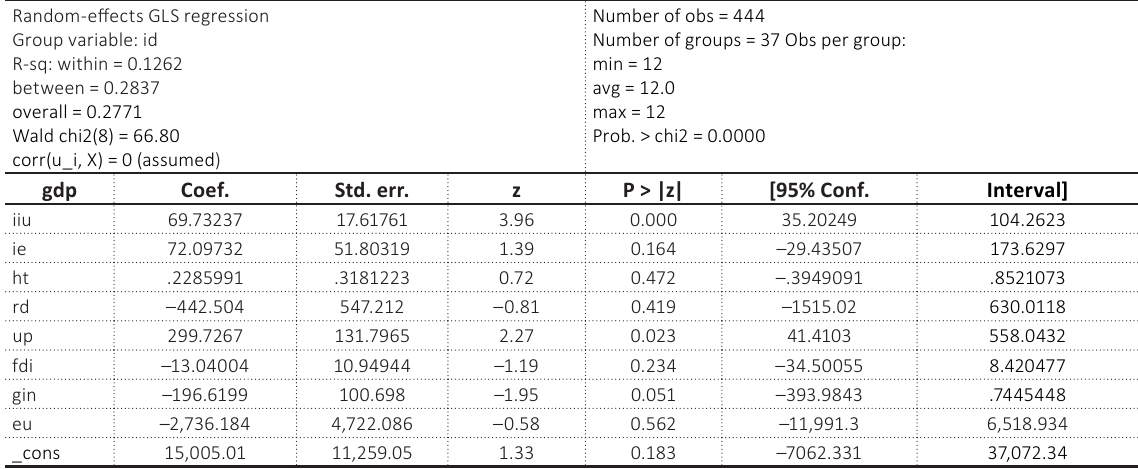
Number of obs = 444 Number of groups = 37 Obs per